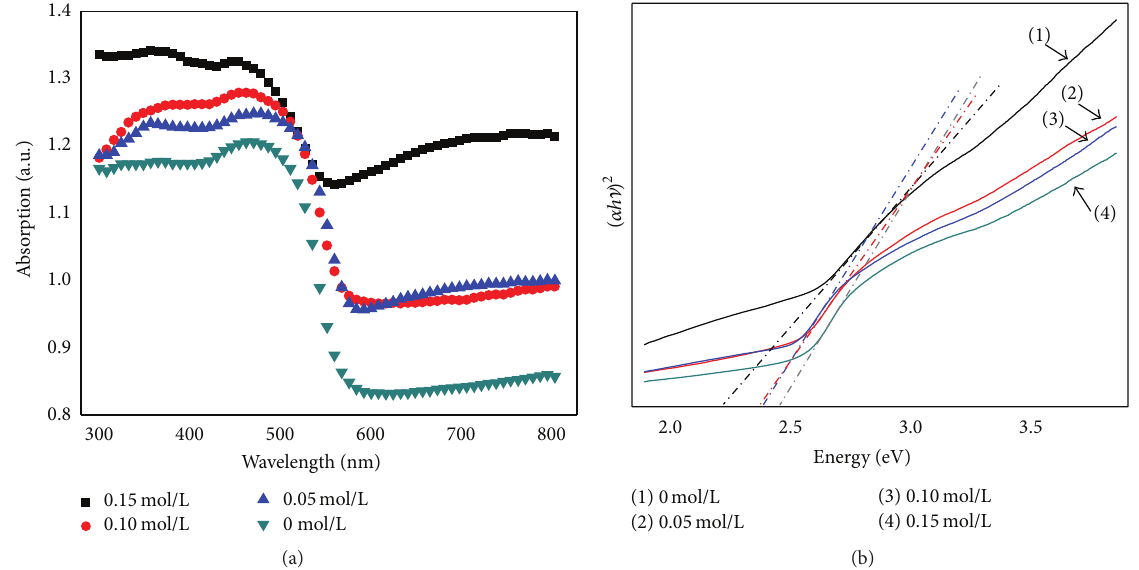
Figure 3: (a) Absorption of CdS/Si-NPA, (b) the plots of (𝛼ℎ ] ) 2 versus ℎ ] .